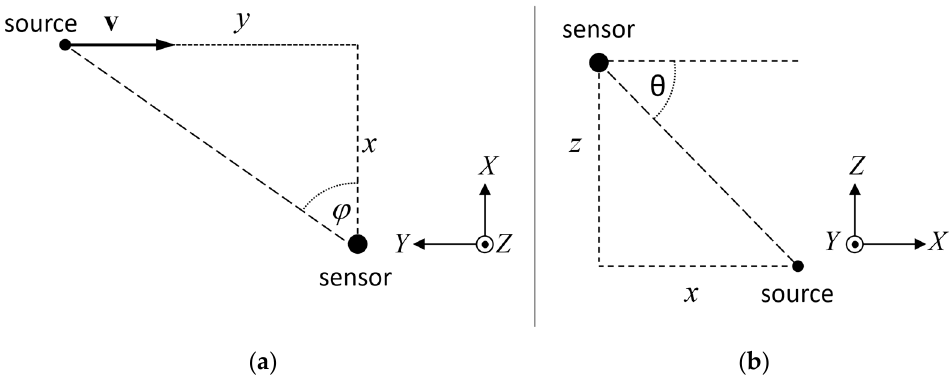
Figure 1. Orientation of the AVS coordinate system: ( a ) top view, ( b ) side view. The sensor position is (0, 0, 0), the sound source position is ( x , y , z ).